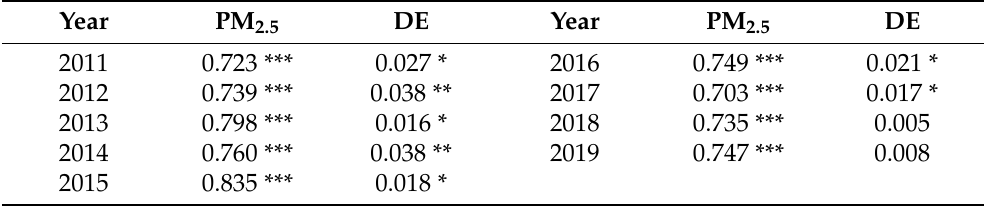
Table 5. Moran’s I of the digital economy and the PM 2.5 concentration.